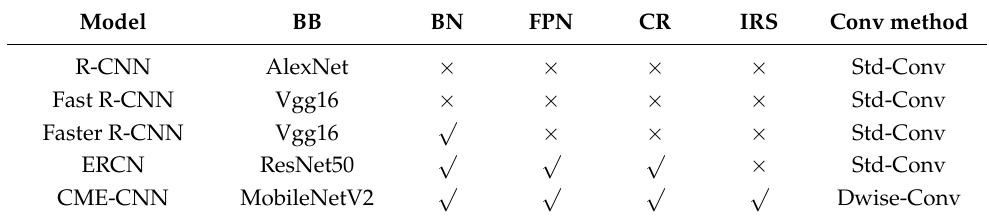
Table 2. Comparison Between Different